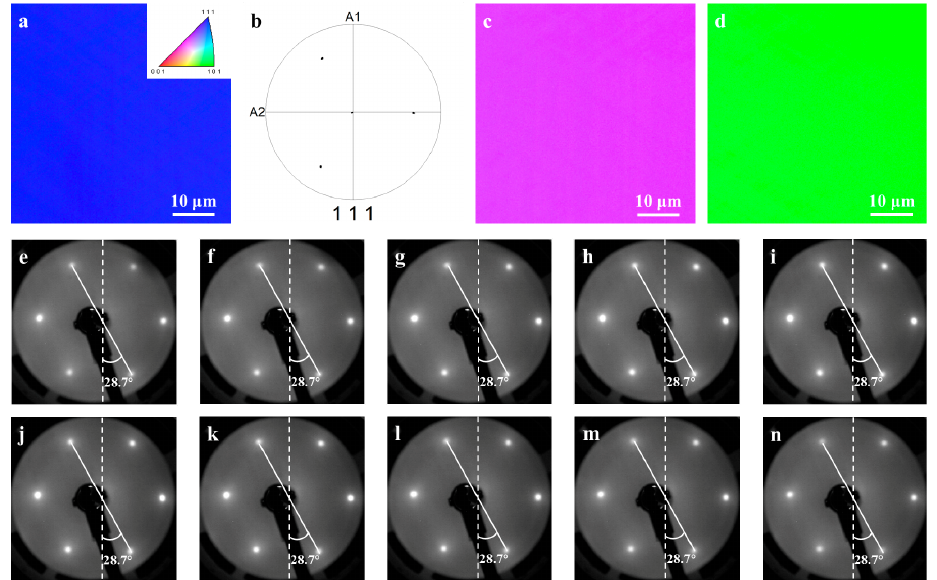
Figure 5. Characterization of the lattice orientation of the graphene/Ni (111) epitaxial interface obtained at 950 ◦ C. ( a ) Out-of-plane EBSD mapping of the Ni (111) thin film after graphene growth. ( b ) The pole figure of the same region. ( c ) In-plane EBSD mapping of Ni (111) thin film after graphene growth in a random direction. ( d ) In-plane EBSD mapping of Ni (111) thin film in the vertical direction. ( e – n ) A series of LEED patterns of monolayer graphene synthesized on Ni (111) film at 950 ◦ C are acquired with a step of 0.5 mm at a primary energy of 106.9 eV. The diameter of the measurement spots is 0.5 mm.